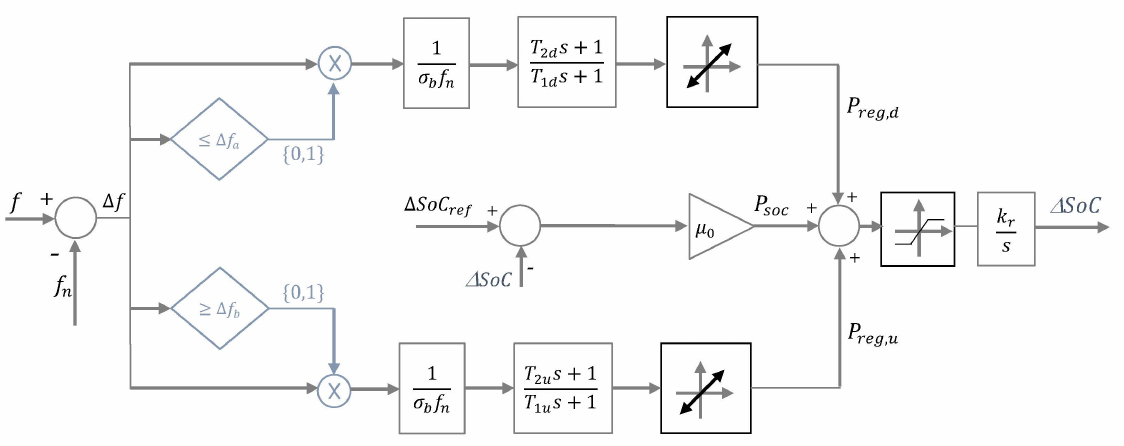
Figure 7. SoC control